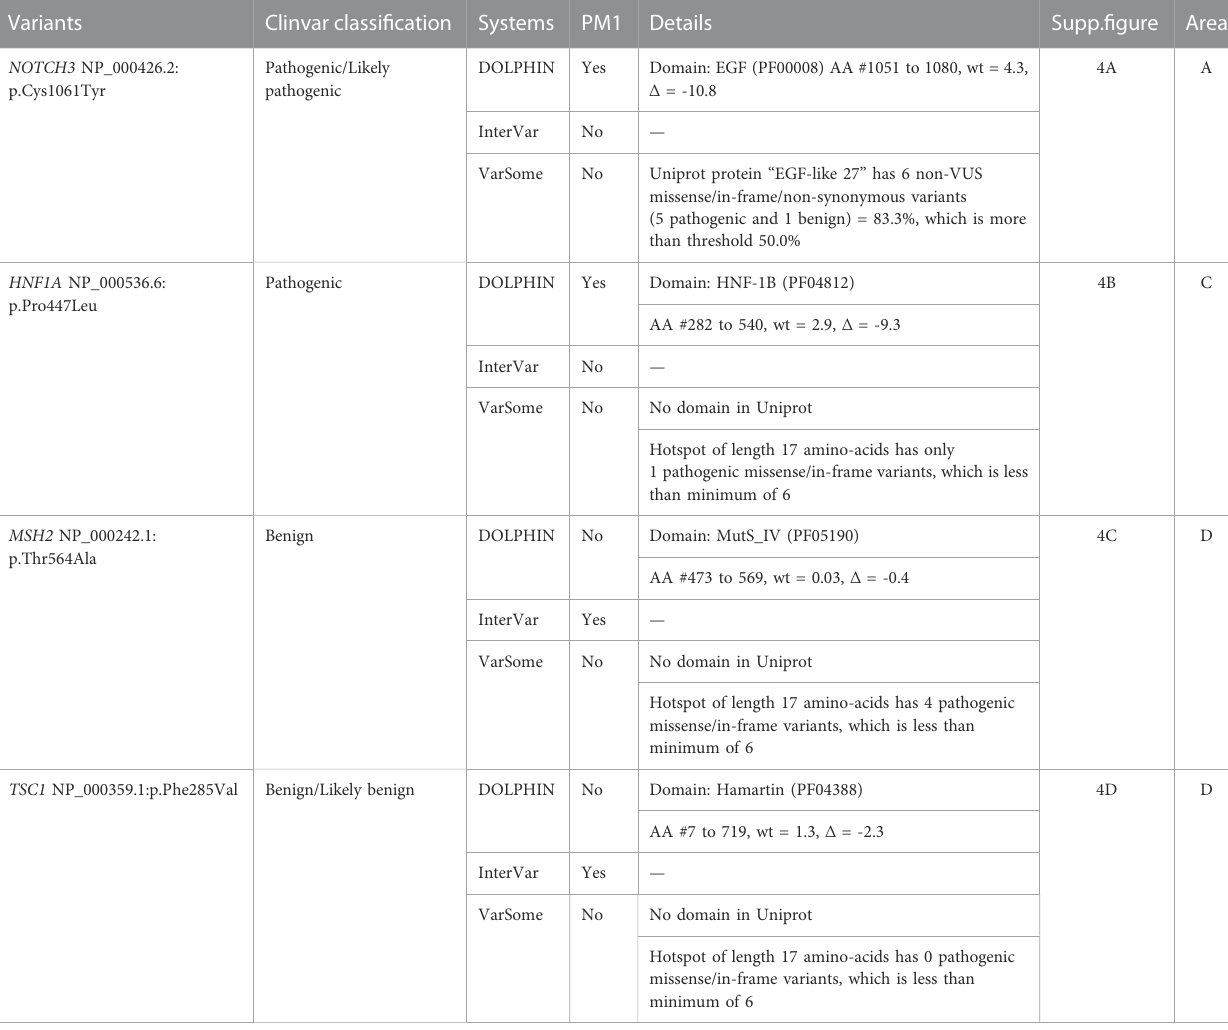
TABLE 2 False negatives and false positives of the InterVar PM1 annotation based on InterVar, DOLPHIN and Varsome. AA = Amino Acid.